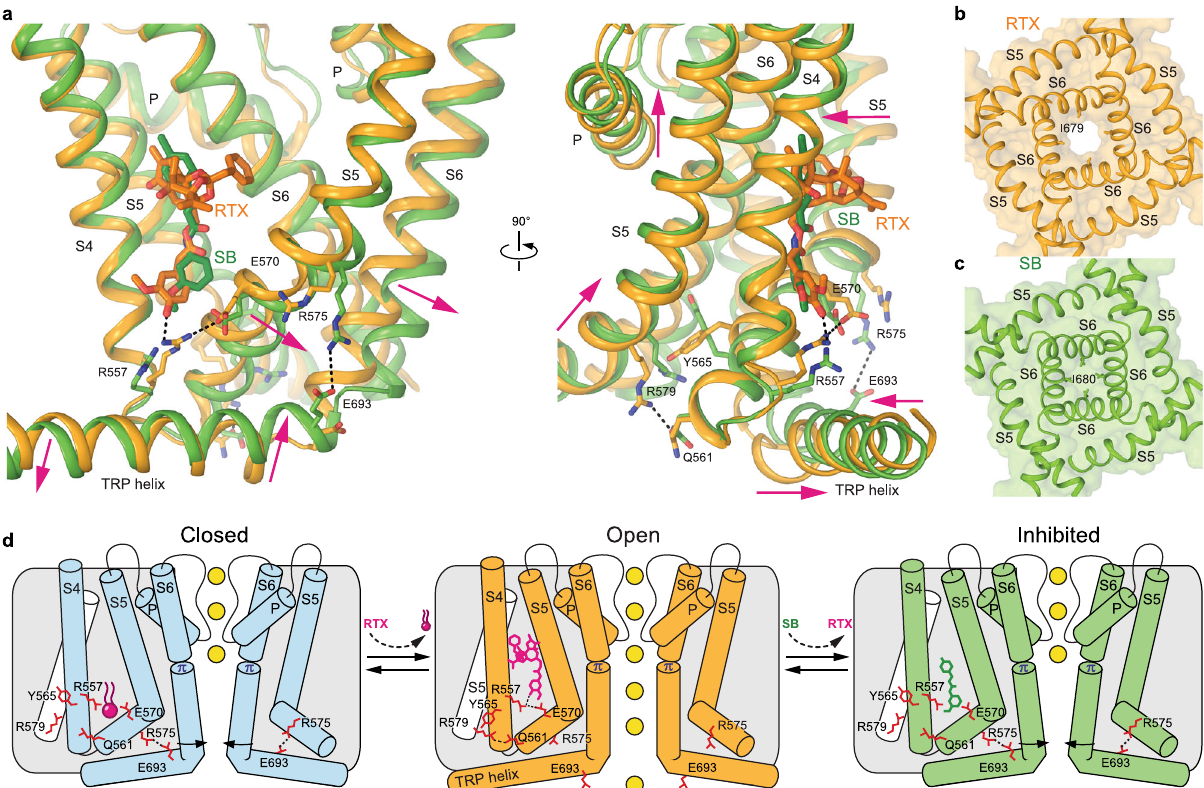
Fig. 5 | Mechanism of hTRPV1 inhibition by SB-366791. a Closeup view of the vanilloid site in superposed RTX-bound open rTRPV1 (orange; PDB ID: 7RQW) and inhibited hTRPV1 SB-366791 (green) structures. Relative movements of domains are